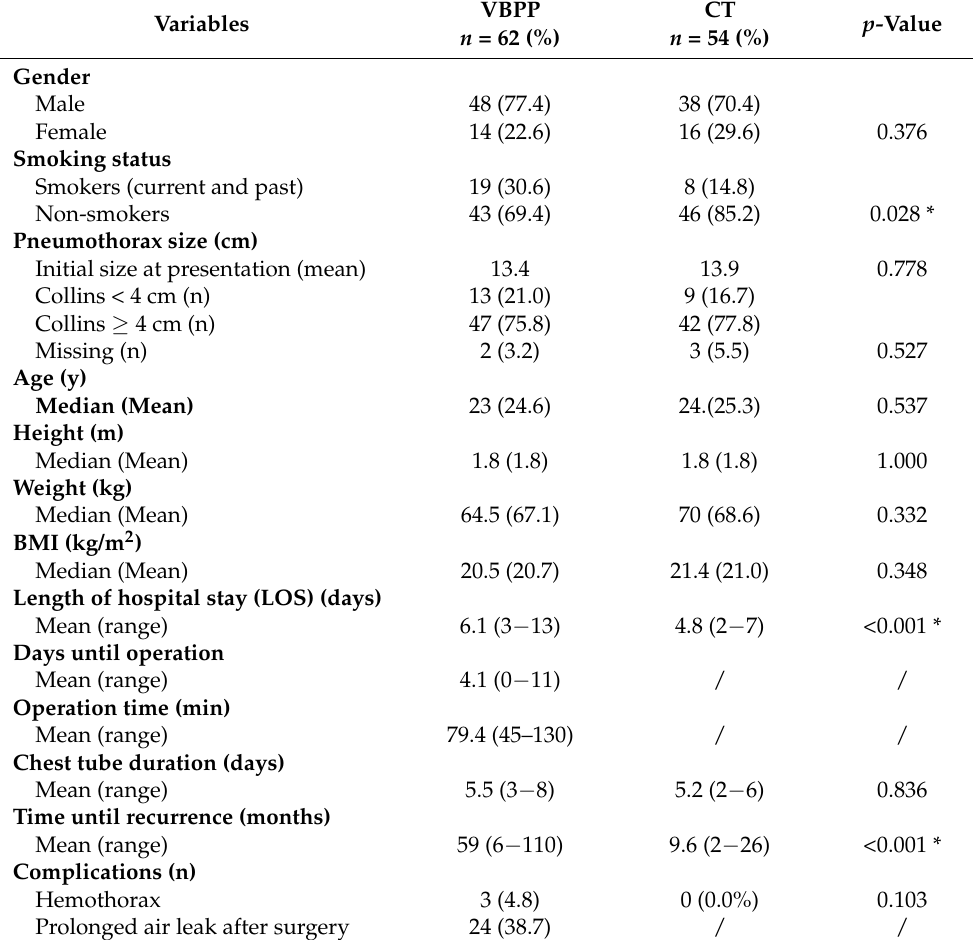
Table 1. Clinical characteristics of the VBPP and CT